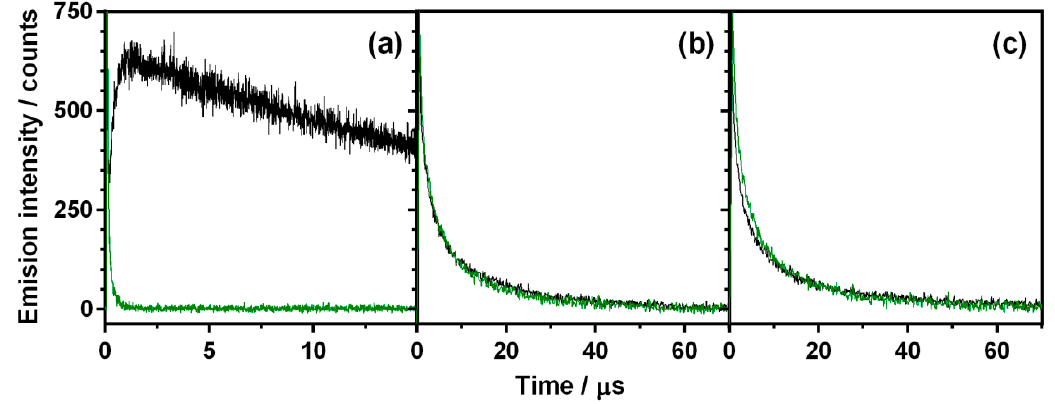
Figure 2. Time-resolved phosphorescence intensity 1275 nm (black) and 1110 nm (green) upon 355 nm pulsed laser excitation of ( a ) ZnPcOBP in toluene; ( b ) MSNP3 in methanol; ( c ) MSNP4 in methanol.